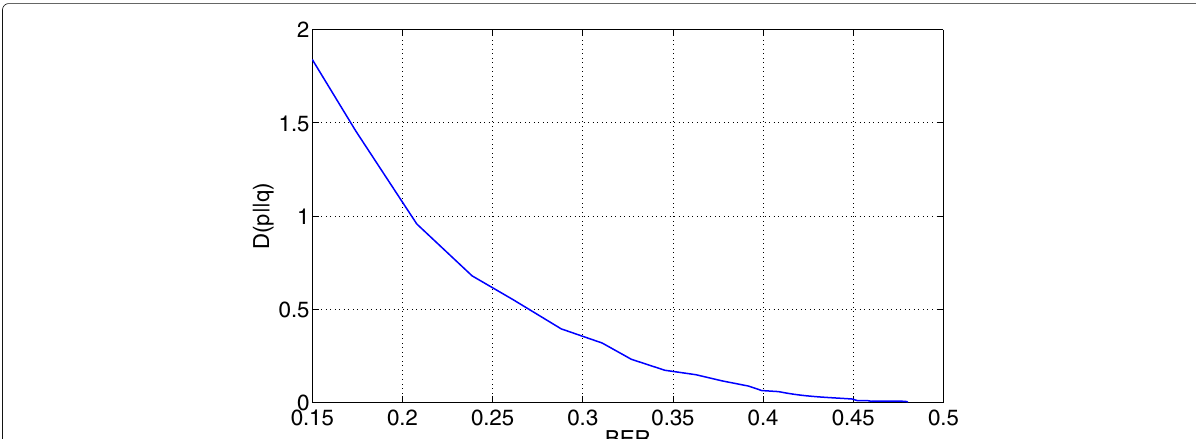
Fig. 9 Kullback-Leibler divergence between distributions of LLRs that correspond to bits in error and LLRs that correspond to correct bits at the output of an LDPC soft decoder, as a function of the hard-decision BER at the output of the decoder. As the BER approaches 0.5, the distributions become more alike, to the point where detecting a correct bit or a bit in error is impossible, even with soft information